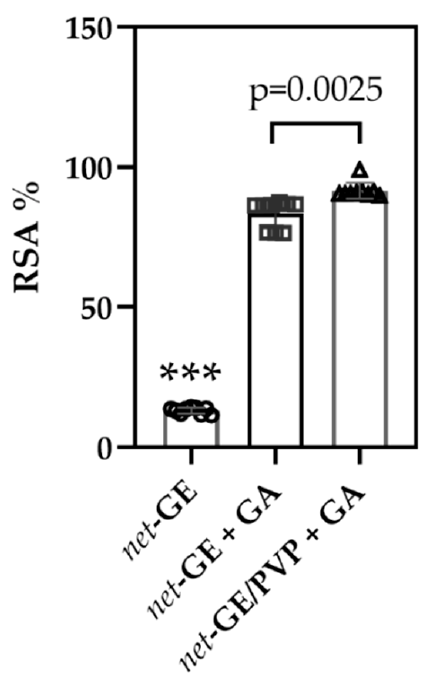
Figure 8. Comparation of radical scavenging activity (RSA%) of net- GE/PVP IPN and net- GE hydrogels functionalized with GA. net- GE was used as a control. A one-way analysis of variance (ANOVA) with Tukey correction was employed for multiple comparisons. It was considered statistically significant when p < 0.05; *** p < 0.0001.